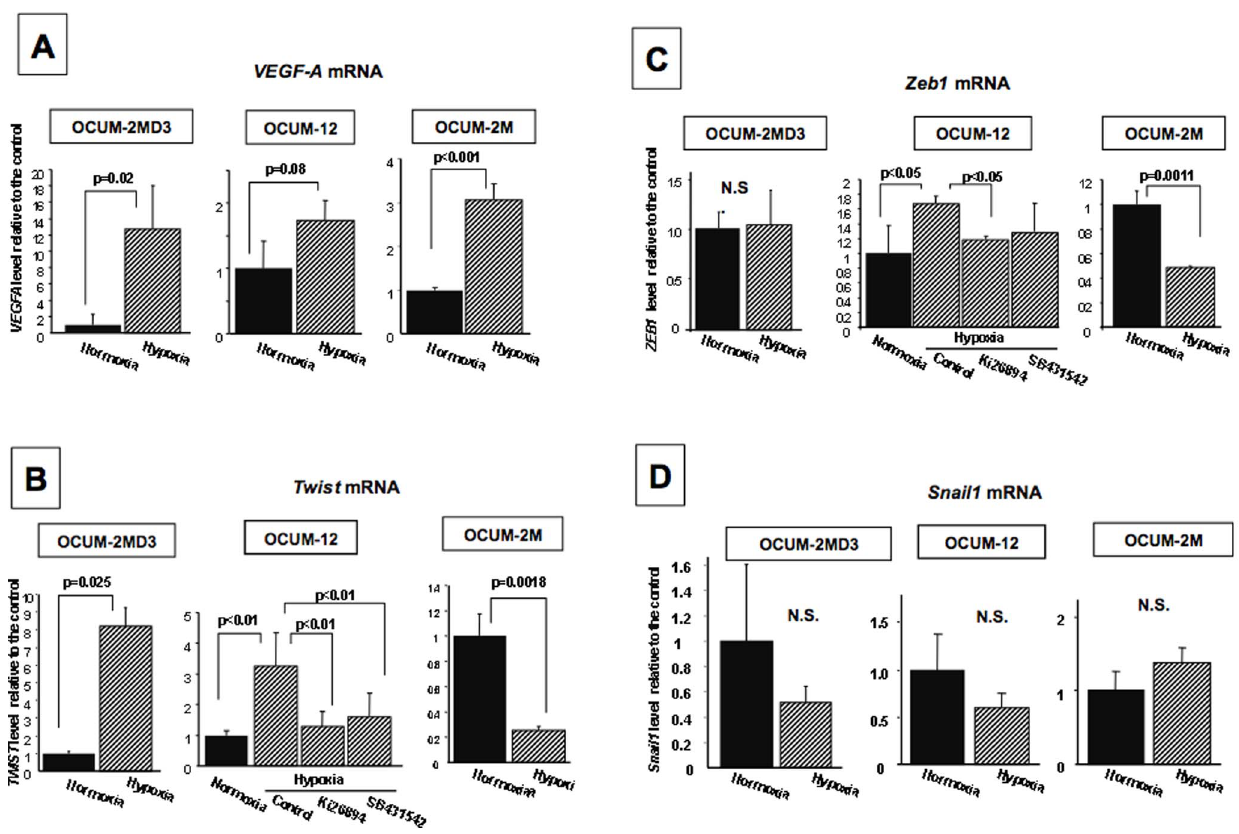
Figure 6. Effects of hypoxic condition on the transcription factors associated with mesenchymal transition. (A) A hypoxia-target molecule, VEGF-A mRNA level in OCUM-2M, OCUM-2MD3, and OCUM-12 was increased under hypoxia. (B, C) Hypoxic condition significantly increased the expression level of Twist and Zeb1 in OCUM-2MD3 and OCUM-12 cells, but not that in OCUM-2M cells. (D) The expression level of Snail1 was not affected by hypoxic condition.